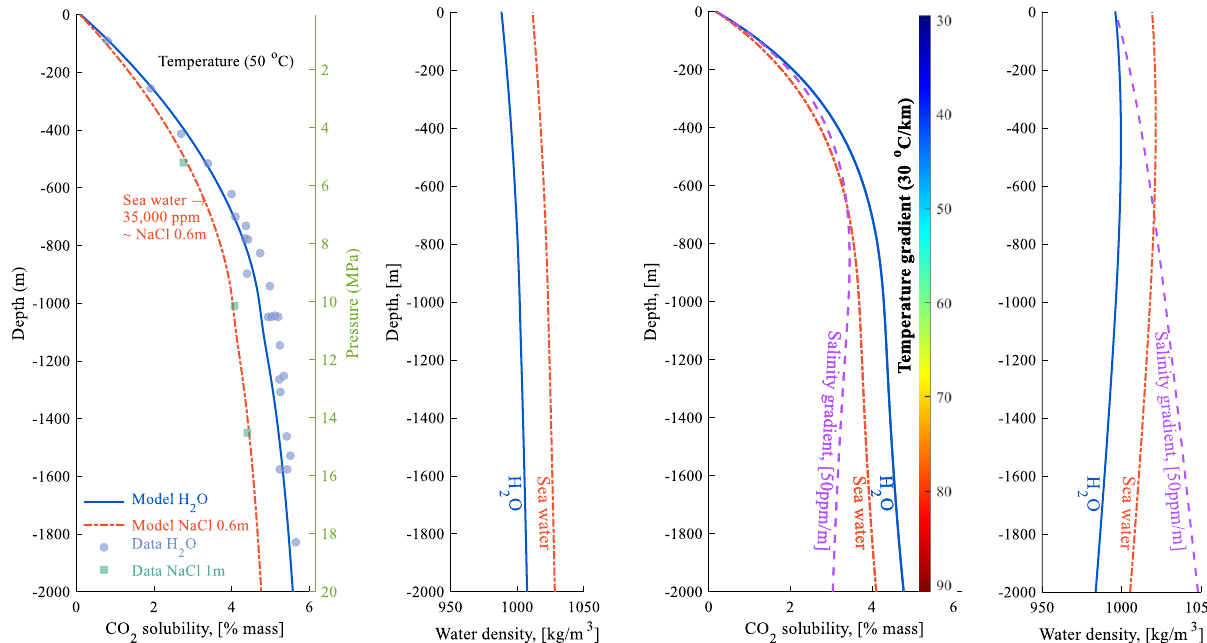
Figure 2. The left pair of plots show CO 2 solubility and density of CO 2 -saturated water as a function of depth. The temperature in the system is constant at 50 °C and two salinity cases are shown (0 ppm—pure water; and 35,000 ppm—seawater). The experimental data shown for CO 2 solubility was compiled by (circle filled with blue colour)Appelo et al. 50 and (square filled with green colour) Koschel et al. 51 . The right pair of plots show CO 2 solubility and CO 2 -saturated water density as a function of depth, assuming a temperature gradient of 30 °C/km. Three salinity cases are shown; pure water, seawater, and a vertical salinity gradient of 50 ppm/m. The model results were calculated using ECO2N EOS in TOUGHREACT. A normal hydrostatic pressure gradient was assumed for all cases, as shown on the secondary y-axis of the left-most